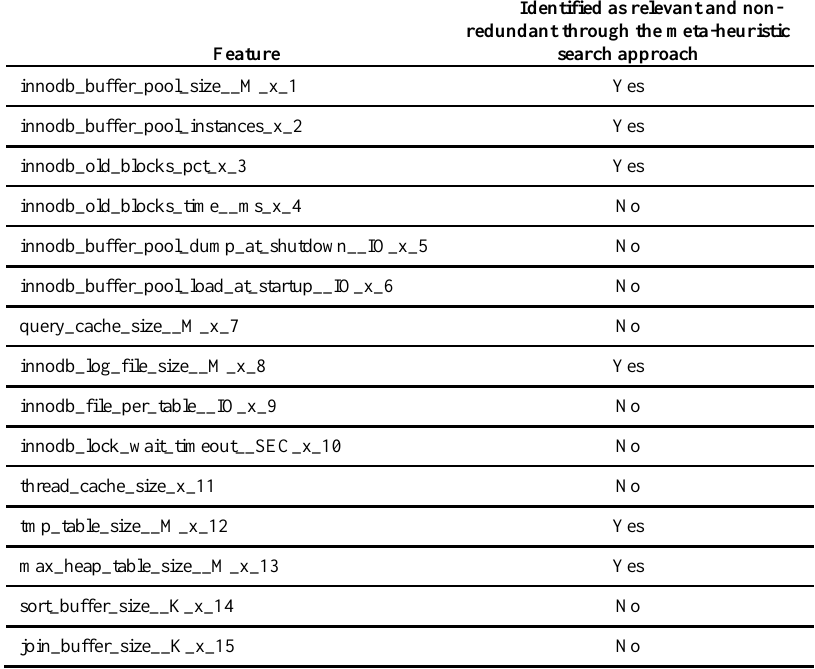
Table 2. List of